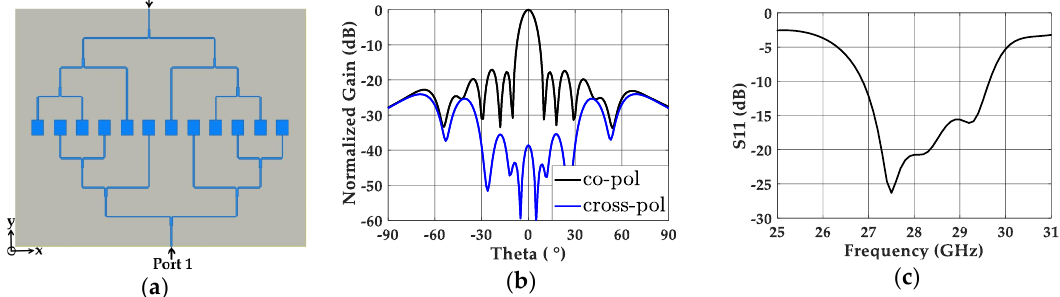
Figure 6 . ( a ) Top view of the non-uniformly powered and uniformly spaced 12-element patch array. ( b ) Simulated normalized gain of the non-uniformly powered and uniformly spaced 12-element patch array with co- and cross-polarization. ( c ) Simulated S 11 of the same antenna array.